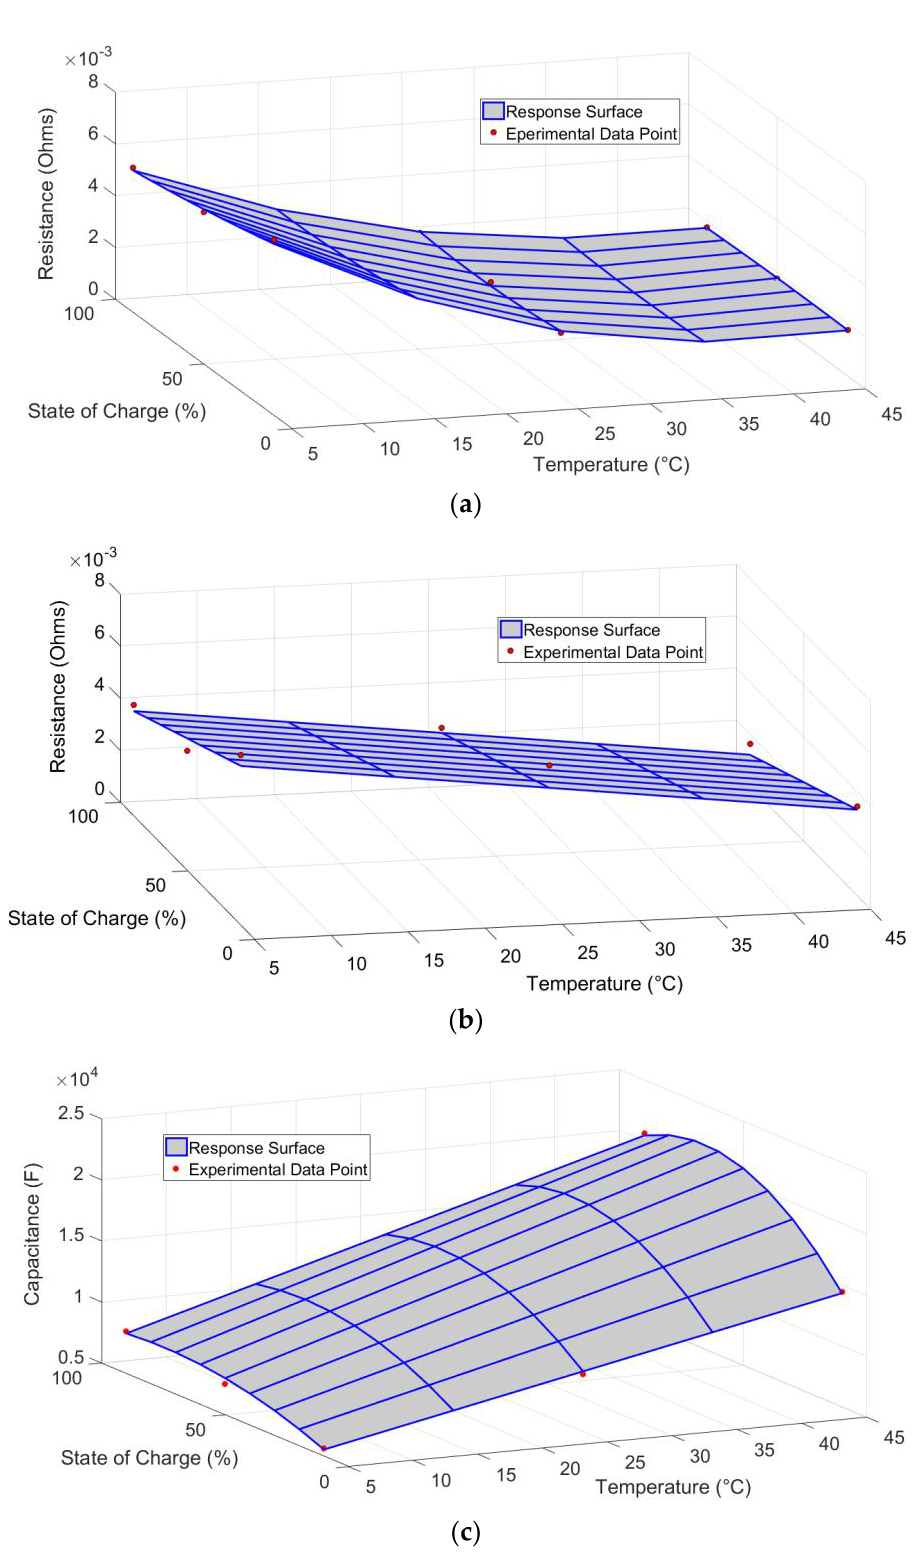
Figure 10. Response surface plots and experimental data for: ( a ) ohmic resistance; ( b ) Thevenin resistance; and ( c ) Thevenin capacitance parameters.